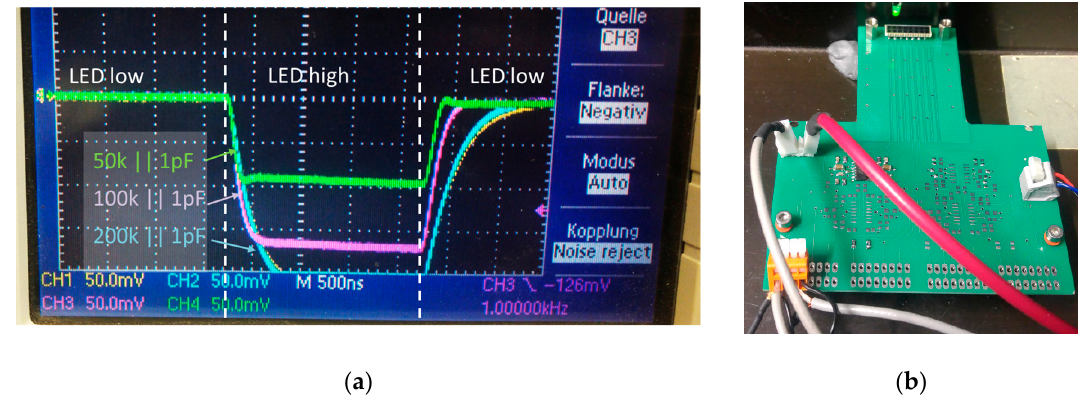
Figure 8. ( a ) Signal response of the differently dimensioned trans-impedance amplifier (TIA) stages coupled to a single APD element (S8550) that is exposed for 2 µs with a fast light-emitting diode (LED) with ( b ) corresponding test setup.